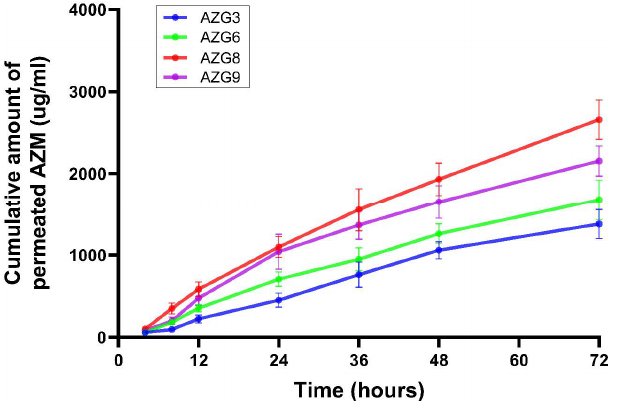
Figure 5. Cumulative permeated drug from ex vivo mucosal permeation model. Data are mean ± SD, n = 3.